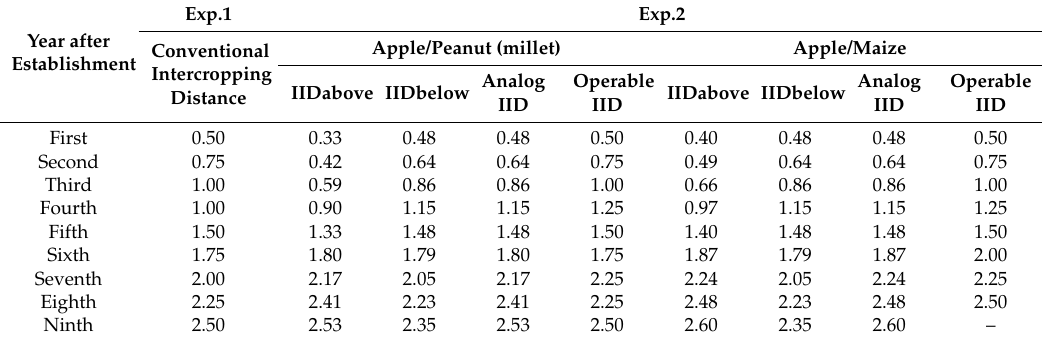
Table 2. Intercropping distance (m) between apple trees and crops in the alley cropping systems. Exp. is the abbreviation of the experiment. IID is the abbreviation of the improved intercropping distance. Exp.1 Exp.2 Year after Apple/Peanut (millet) Apple/Maize Conventional Establishment Intercropping Analog Operable Analog Operable IIDabove IIDbelow IIDabove IIDbelow Distance IID IID IID IID First 0.50 0.33 0.48